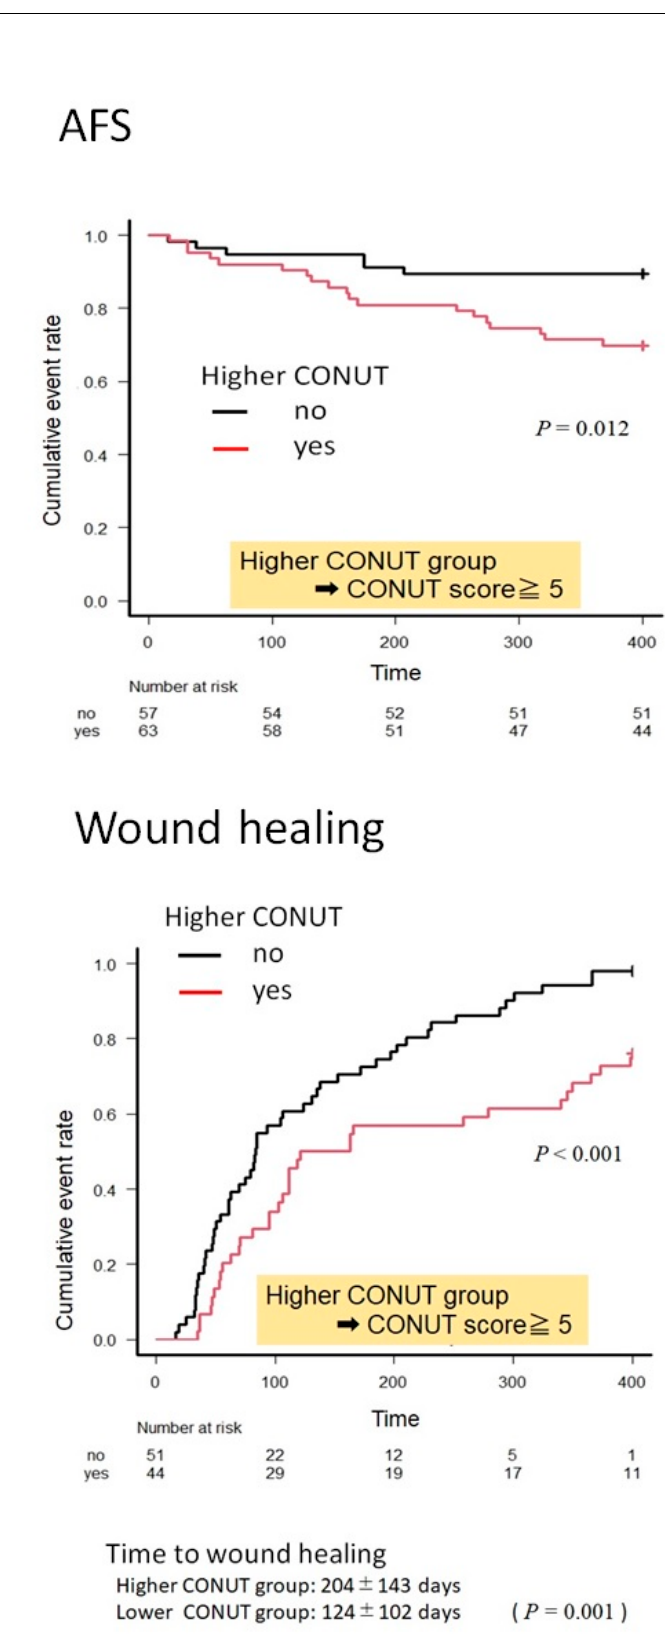
Figure 3. Kaplan–Meier curves for amputation-free survival (AFS) ( A ) and wound healing ( B ) in the higher and lower controlling nutritional status (CONUT) groups.